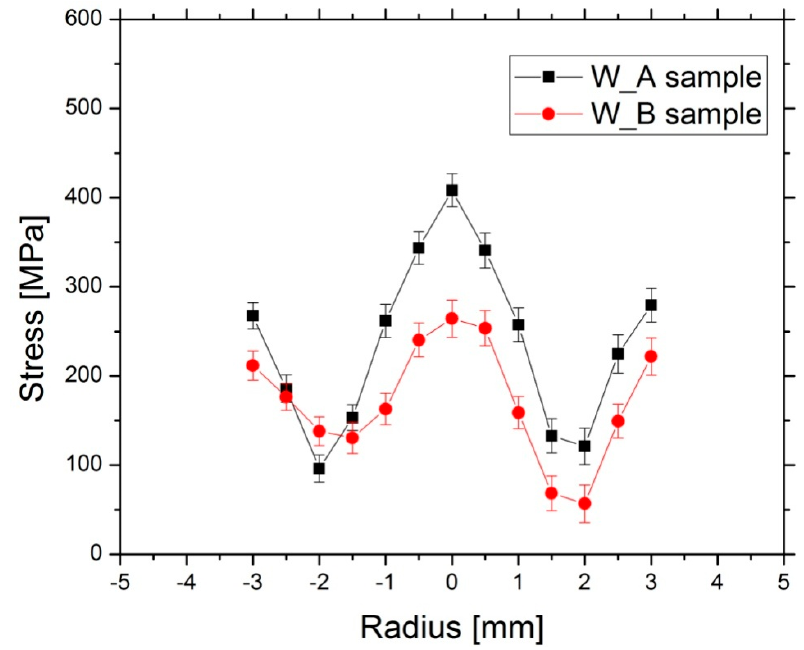
Figure 6. The stress calculated using von Mises formula (4) from the measured differences of the stresses for W_A and W_B samples.